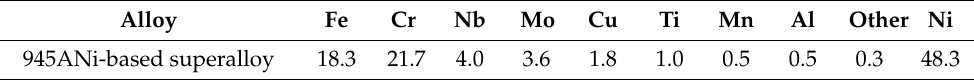
Table 1. The chemical composition (in weight percentage, wt.%) of the 945A Ni-based superalloy. Alloy Fe Cr